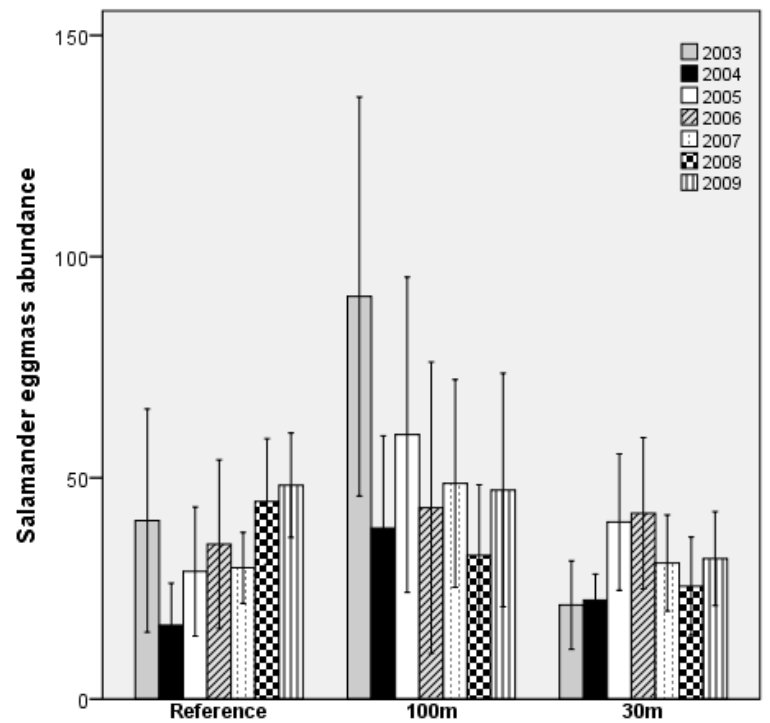
Figure 2. Mean (±1 SE) annual abundance of spotted salamander eggmasses deposited in 11 natural ephemeral pools across 3 experimental forestry treatments in east ‐ central Maine, USA. Treatments were: reference (uncut), 100 m undisturbed buffer, and 30 m undisturbed buffer. Eggmass data from 2003 was collected prior to the experimental cut; eggmass data from 2004 through 2009 were collected post ‐ cut.